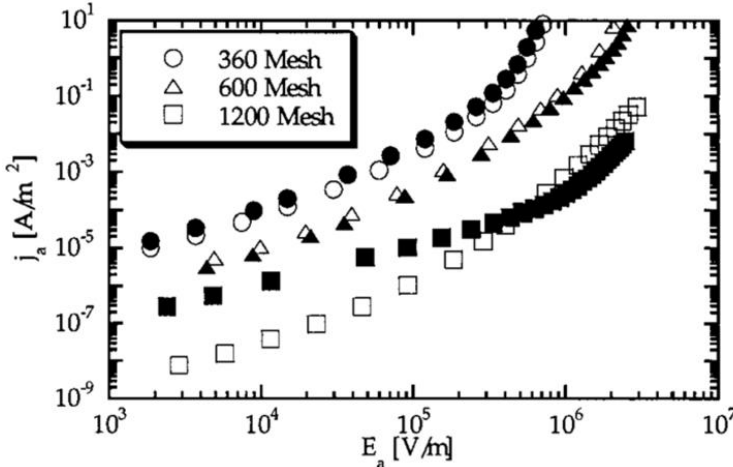
Figure 18. Current density as a function of the average applied electric field. Green, n-type SiC powders of different grain sizes at room temperature. Open/closed symbols define dry/moist samples. Reprinted from ref. [64] Copyright 2001 AIP Publishing.